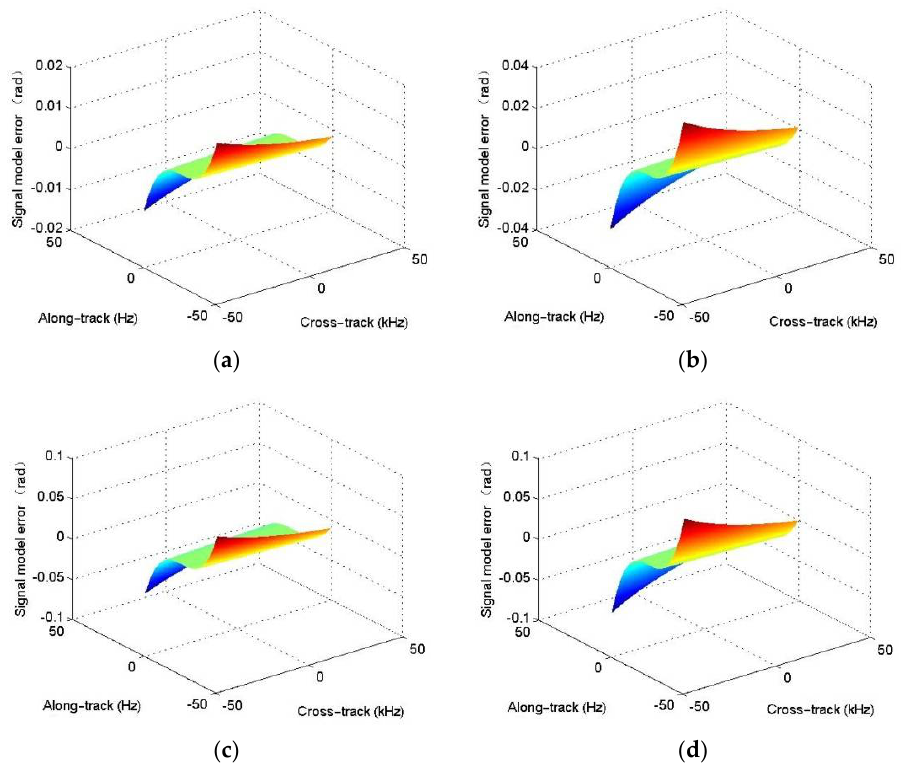
Figure 4. Signal model error for the first transmitter/receiver pair when the system works with wide-bandwidth. ( a ) r = 40 m; ( b ) r = 110 m; ( c ) r = 180 m; ( d ) r = 250 m.